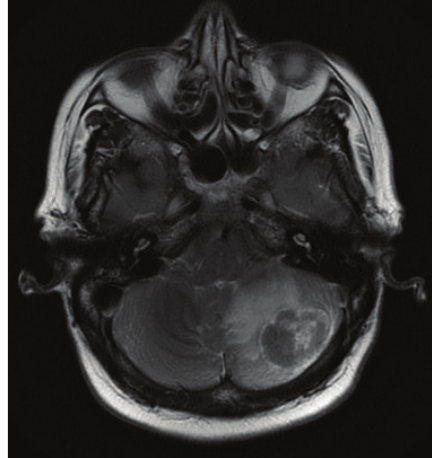
Figure5:Magneticresonanceimaging(axialview)ofbrainshowing a 4 × 4 cm heterogeneous mass in the left cerebellar hemisphere associated with edema (the third case).